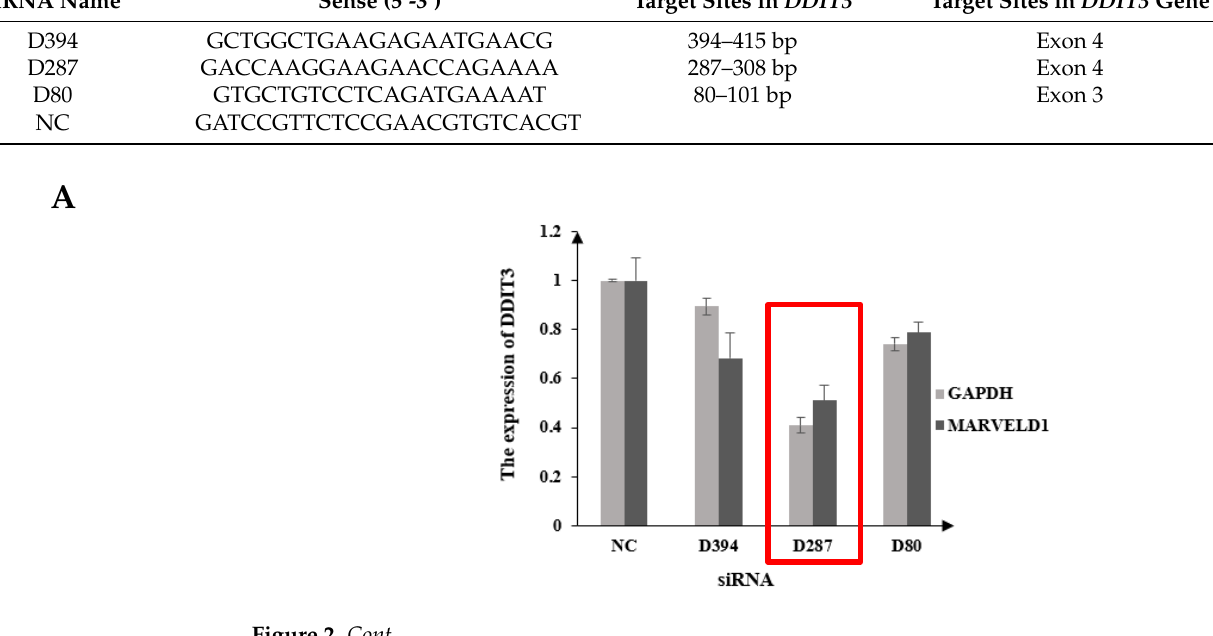
D287 Figure 2. shRNA interference of DDIT3 and its effect on MAC-T cells. Note : ( A ) The shRNA interference effects of LV3- DDIT3-D287 in MAC-T cells. ( B ) Lipid accumulation of NC and LV3-DDIT3-D287 groups in MAC-T cells by Oil Red O staining; NC-versus Ctrl group and D287-LV3-DDIT3-D287 group. ( C ) Calcein-AM/PI staining assays.